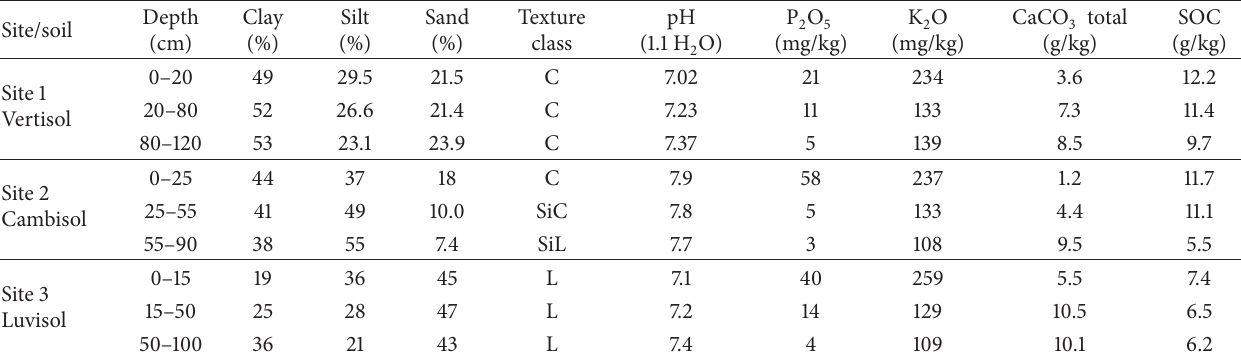
Table 1: Selected soil characteristics at the different sites (Merchouch, Morocco).